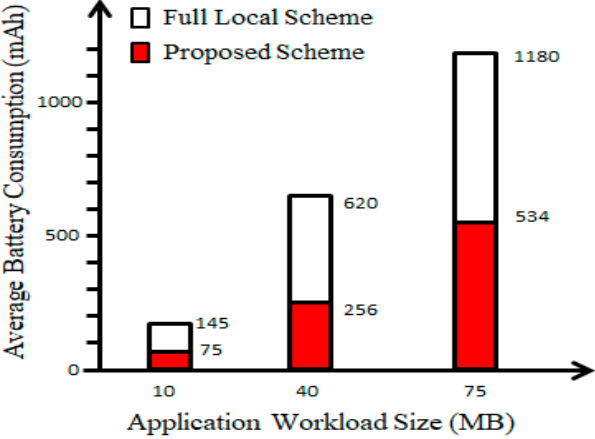
Figure 10. Average battery consumption of full local scheme and proposed scheme.